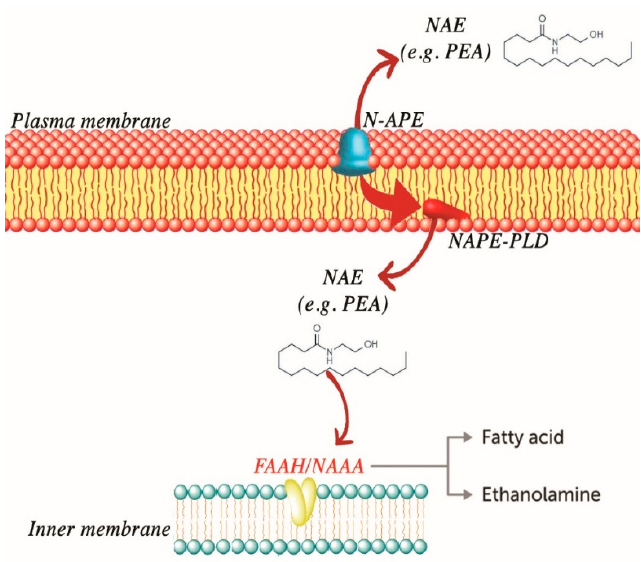
Figure 1. Biosynthesis and degradation of palmitoyl ethanolamide (PEA).